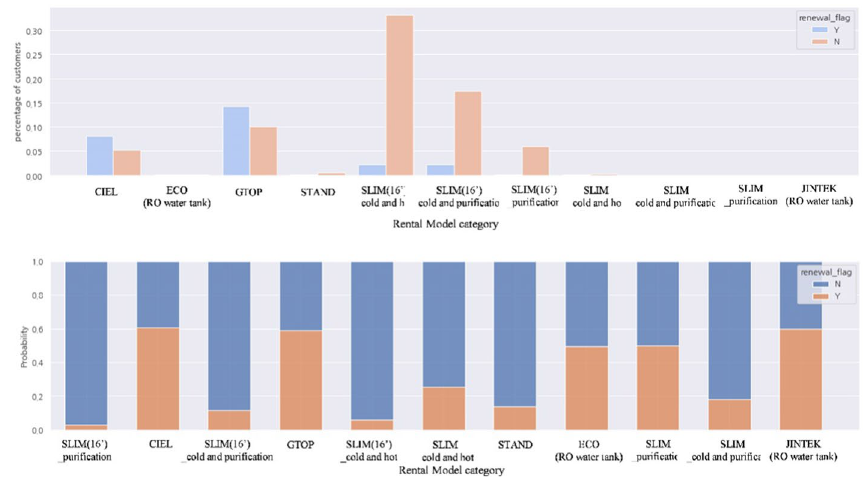
Fig. 9 Results of comparative analysis by renewal (Y/N)—rental model category